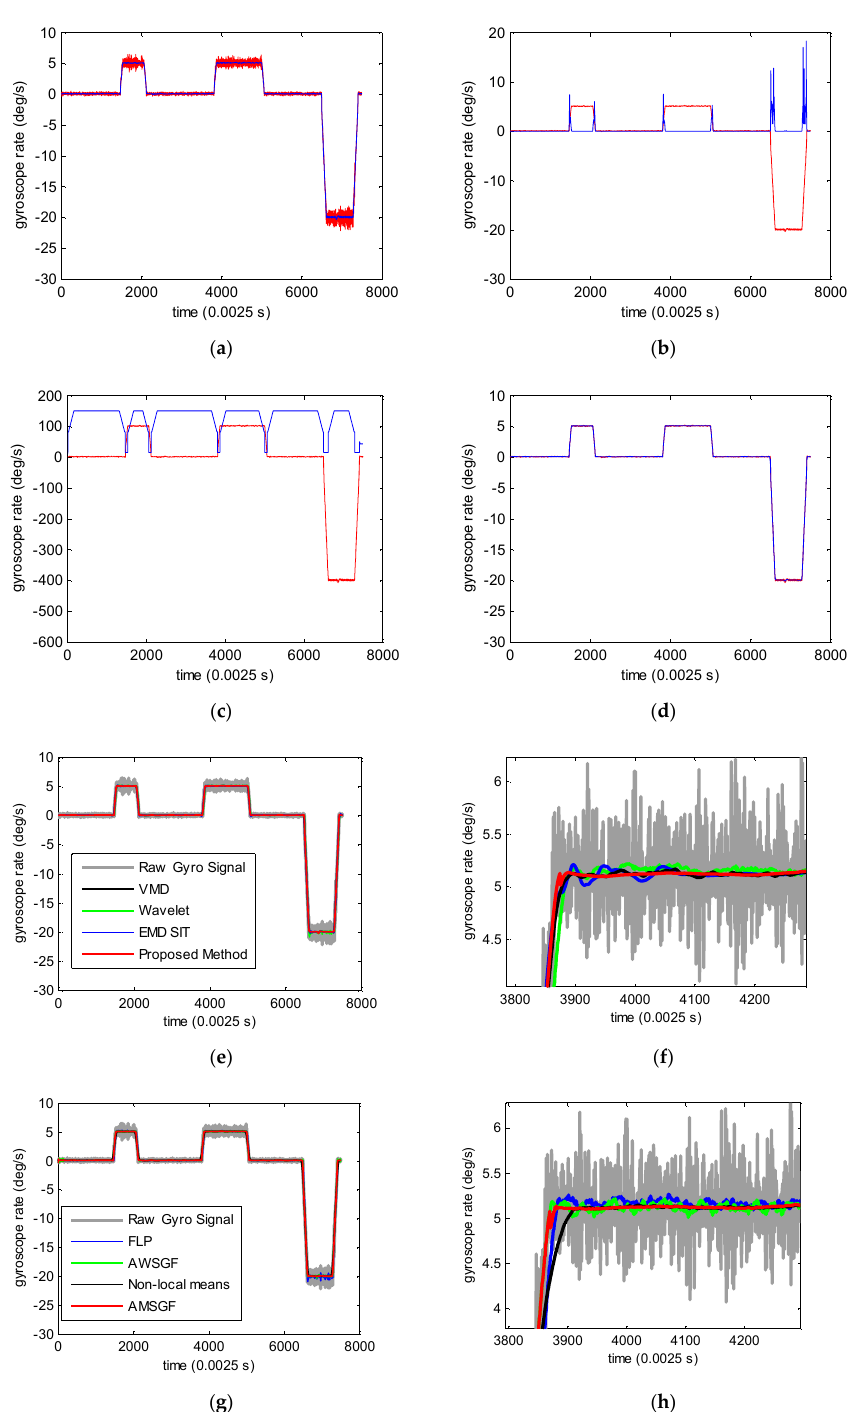
Figure 7. Regular multiple-rate motion experiments. ( a ) ACMP results (red: original gyroscope signal; blue: ACMP results). ( b ) Sample variance (red: ACMP results; blue: 50,000 times magnified sample variance). ( c ) The window size for di ff erent samples, W max = 151, W min = 15, λ th = 2.5 × 10 − 6 , M = 3 for AMSGF (red: 10 times magnified ACMP results; blue: window size selection of AMSGF for di ff erent samples). ( d ) Final denoising results (red: ACMP results; blue: further denoising results using AMSGF). ( e ) Denoising results of di ff erent methods. ( f ) Local magnified image of denoising results in ( e ). ( g ) Denoising results of di ff erent smoothing methods. ( h ) Local magnified image of denoising results in ( g